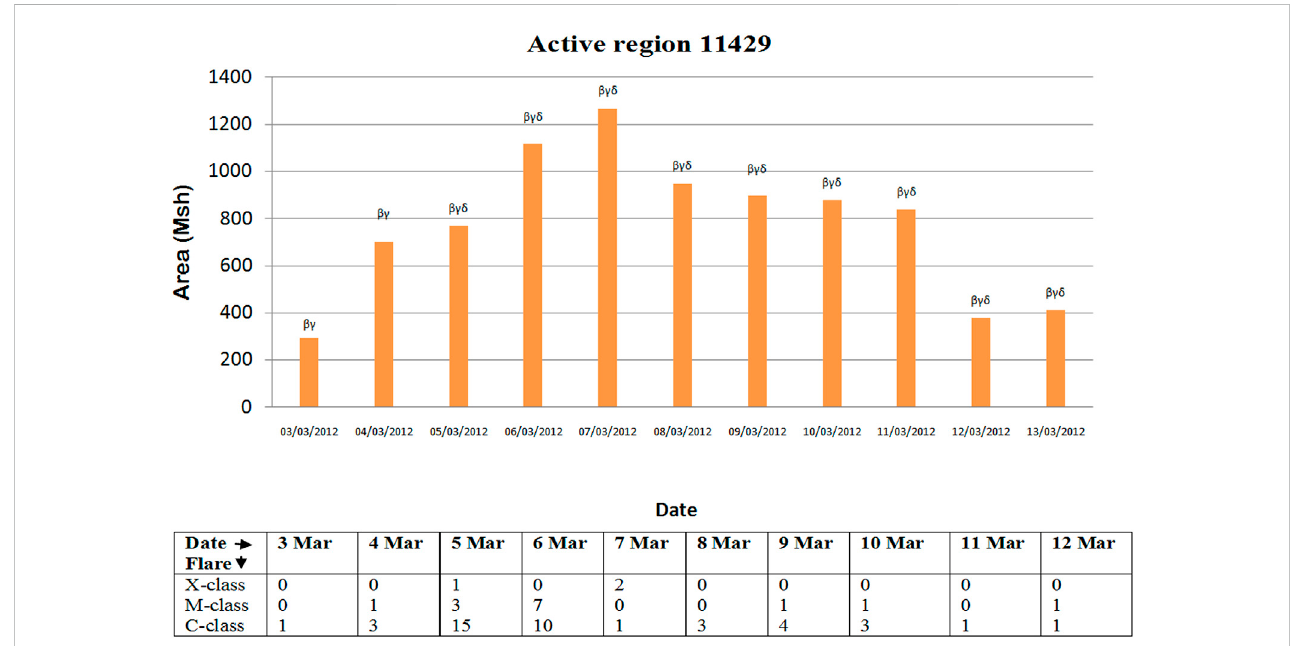
FIGURE 2 Bar chart showing the evolution of active regions in the area and magnetic complexity concerning the